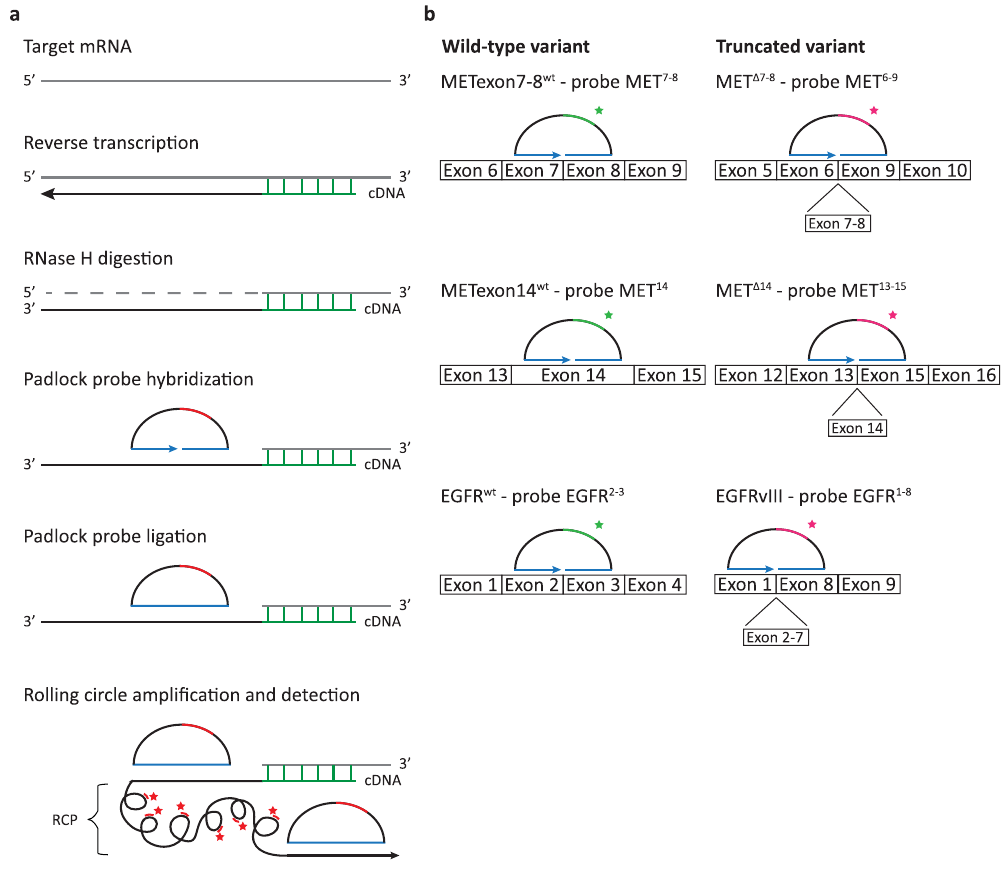
Figure 2. In situ detection of whole-exon deletion splice variants using padlock probes. ( a ) Schematic overview of the method. mRNA is converted into localized cDNA molecules, which can be targeted through padlock probe hybridization and rolling circle amplification. Rolling circle products (RCPs) can then be detected with fluorescently labeled probes. Nucleic acid bridges in the BNA primer are depicted in green, padlock probe target sites are depicted in blue and padlock probe detection sites are depicted in red. ( b ) Design of padlock probes targeting METexon7–8 wt , MET Δ 7-8 , METexon14 wt , MET Δ 14 , EGFR wt and EGFRvIII. For specific detection of transcript splice variants, padlock probes were designed to target the mutation-specific exon-exon junction (detected with magenta fluorescence). For distinctive detection of their associated wild-type variants, padlock probes were targeted at the exon(s) missing in the exon deletion transcripts (detected with green fluorescence). Note that for graphical representation, the figure is not to